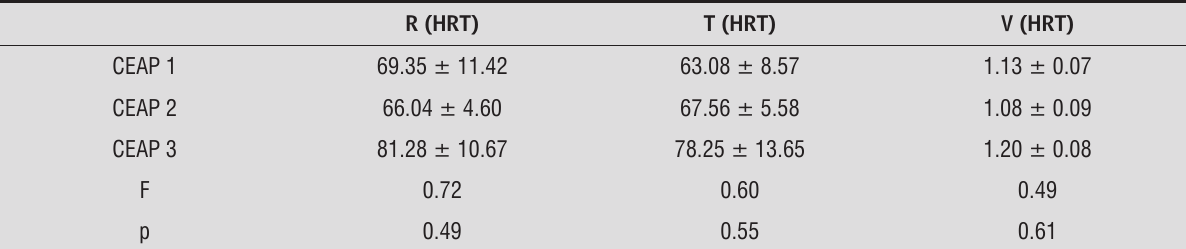
Table 3 - Comparison of different CEAP classes regarding the result of the